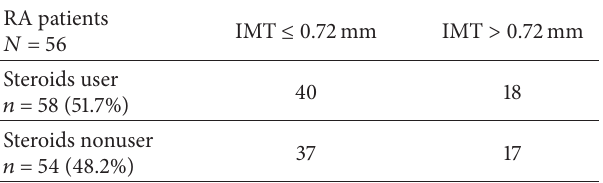
Table 12: Percentages of steroid user to nonusers in RA patients and the relationship with thickened IMT.